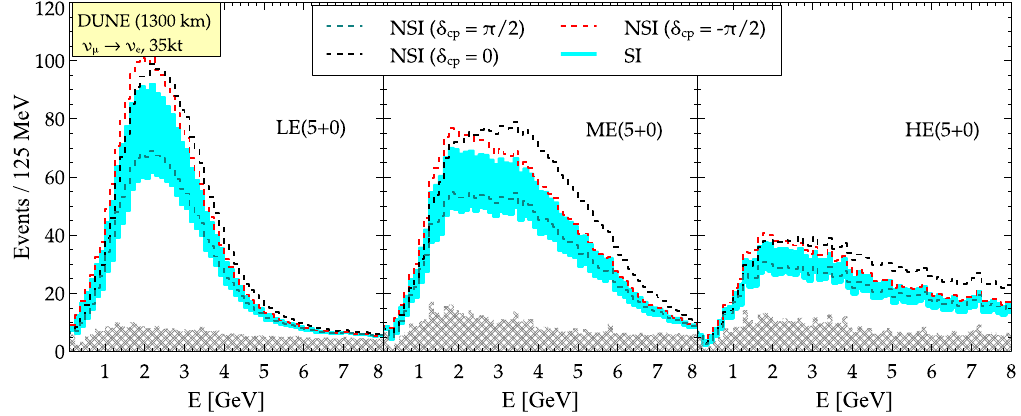
Figure 22.2: Separation between SI ν µ → ν events (cyan band, red and magenta e dashed lines) and NSI ν µ → ν events (black dashed lines) at DUNE with LE (5 + 0), e ME(5 + 0) and HE(5 + 0) beam tunes. The black dashed line is for a CP conserving NSI scenario. The cyan band corresponds to the SI case with the full variation of δ . The dashed lines are for NSI case with different true values of δ . The background events are similar for all the four cases and are shown as grey shaded region. Taken from [ 377 ]